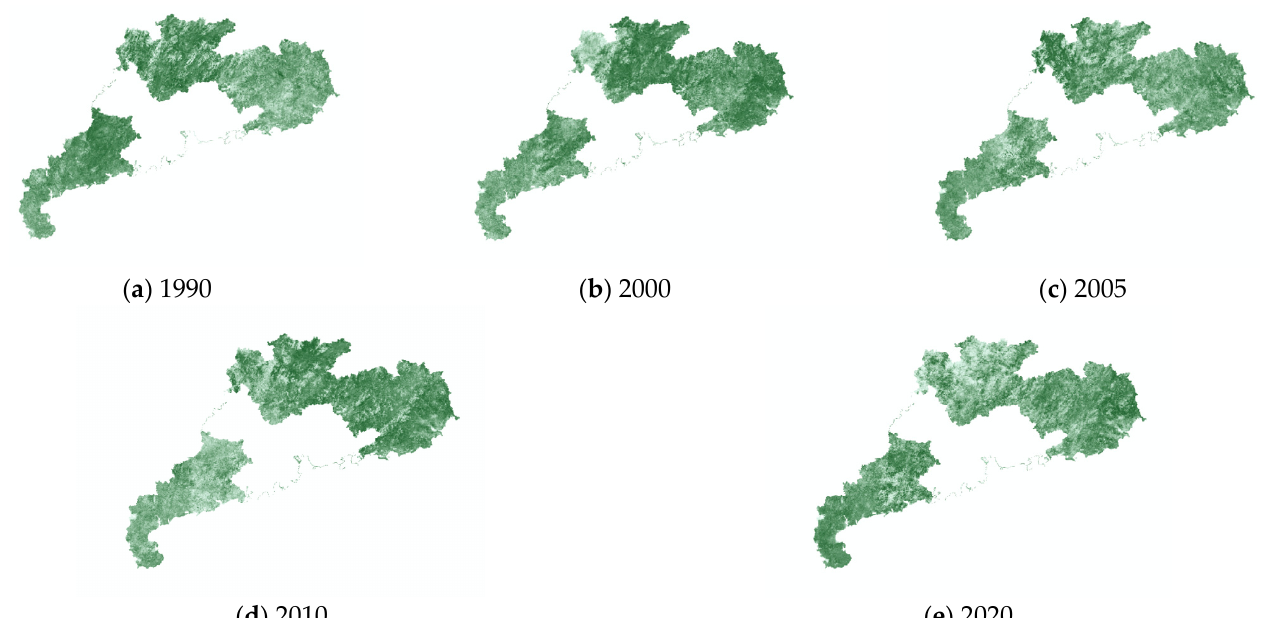
Figure 9. FVC outside the Greater Bay Area.